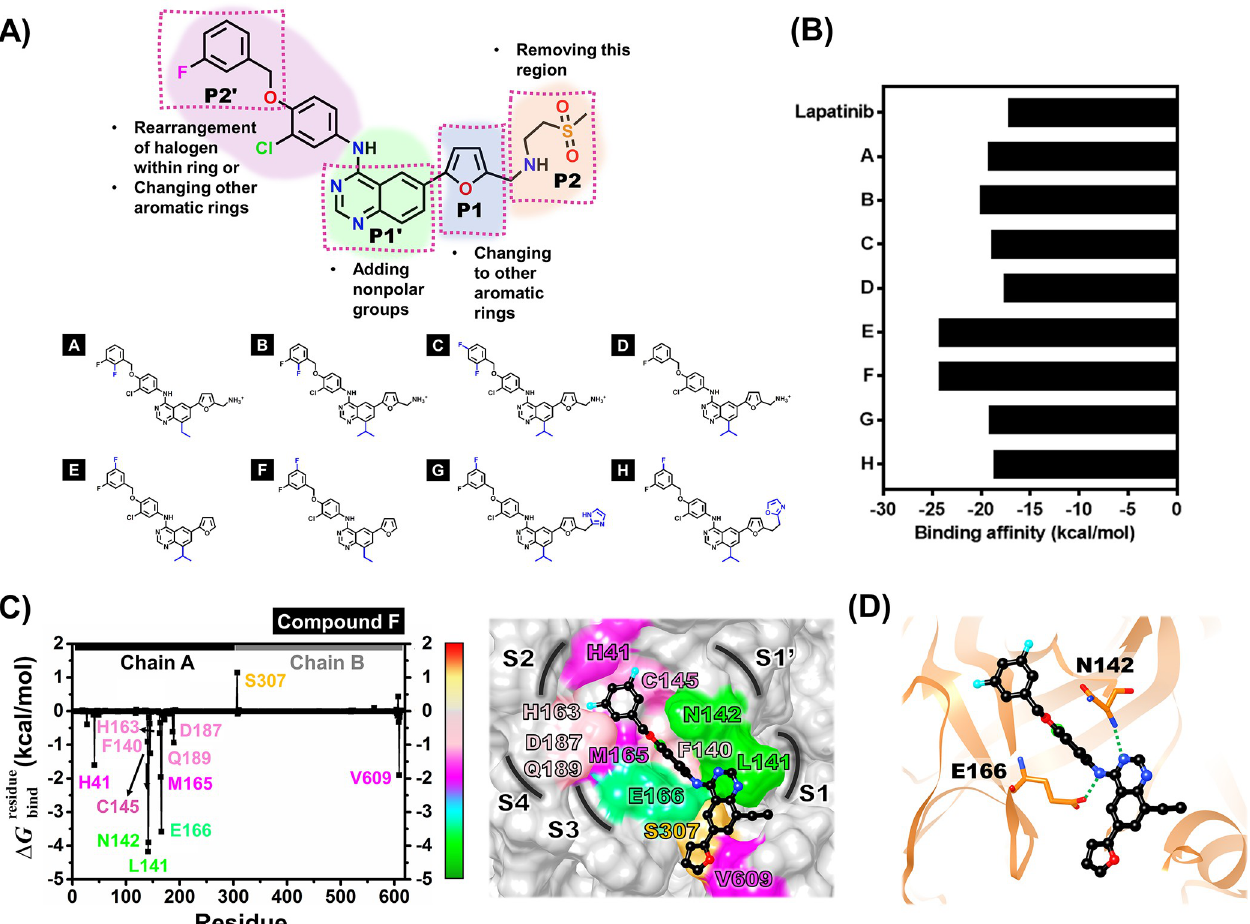
Fig 10. Rational design of lapatinib against the SARS-CoV-2 3CL pro . (A) 2D structure of lapatinib and designed lapatinibs, (B) predicted binding affinity of the designed compounds A-H against SARS-CoV-2 3CL pro in comparison with lapatinib using LigandScout 4.4.2 program, (C) the binding free energy per residue of modified lapatinib, compound F/SARS-CoV-2 3CL pro complex, and its hydrogen bond interactions (D). The results were obtained from one snapshot of the complex after system minimization.